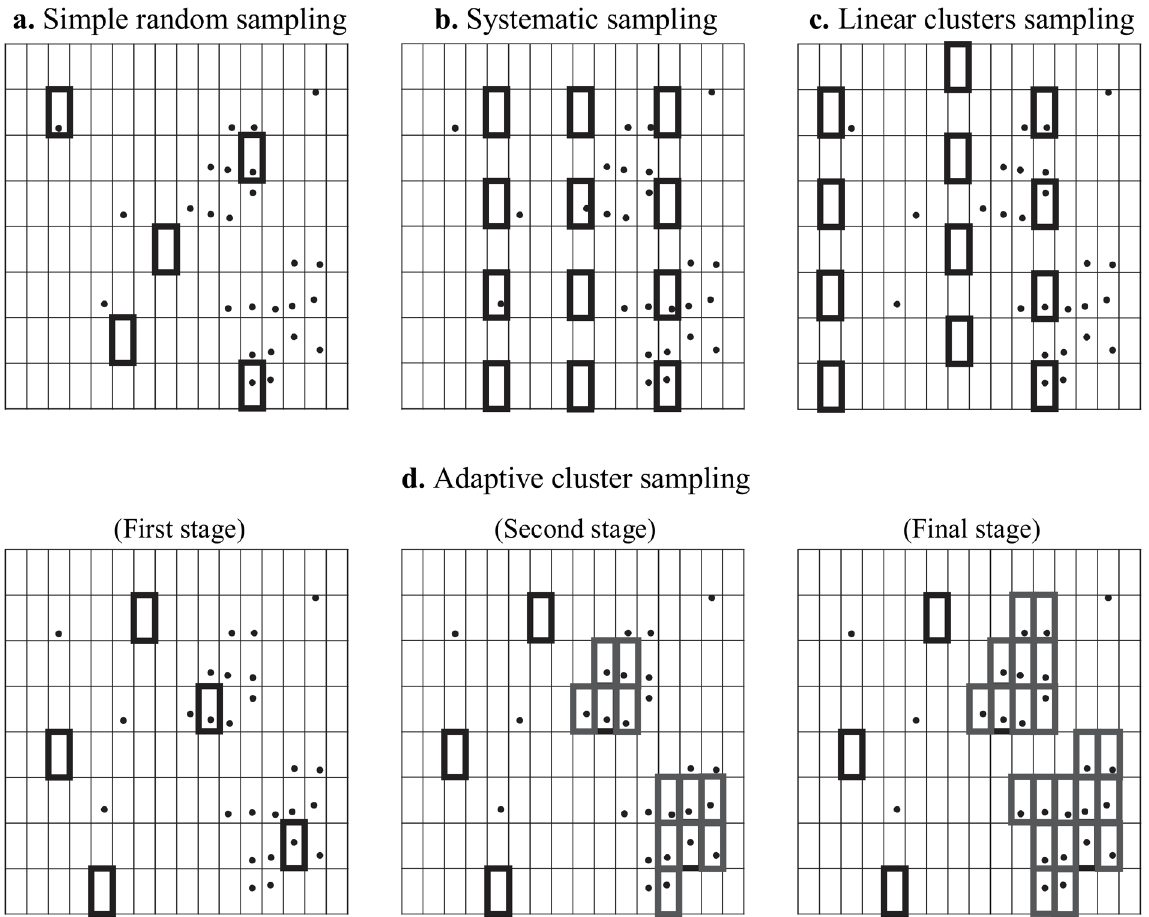
Figure 1 - Plots allocation structure in the sampling